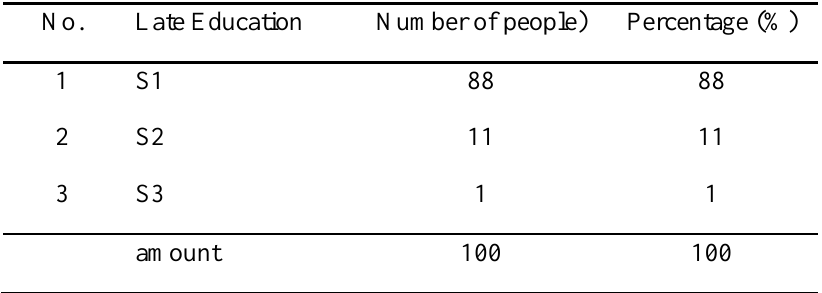
Respondents Based on